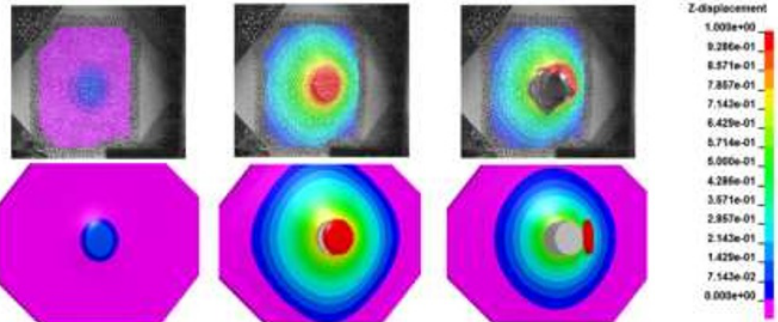
Fig. 10. Clamped plate perforation with flat nose projectile: comparison of Z-displacement of the back face (Arbitrary Unit, 0.4ms interframe) between 3D-DIC analysis (top) and simulation